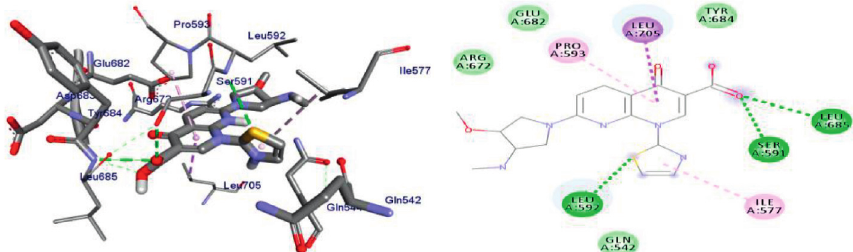
Figure 10: The binding interactions of vosaroxin against human topoisomerase II α (PDB ID: